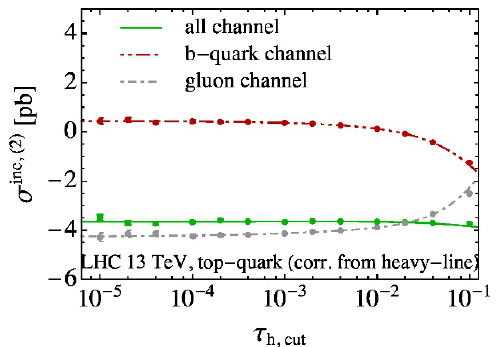
Figure 8 . Cut-o(cid:11) dependence of di(cid:11)erent partonic channel contributions at NNLO from the heavy- quark line for the total inclusive cross section for top-quark production at 13 TeV.